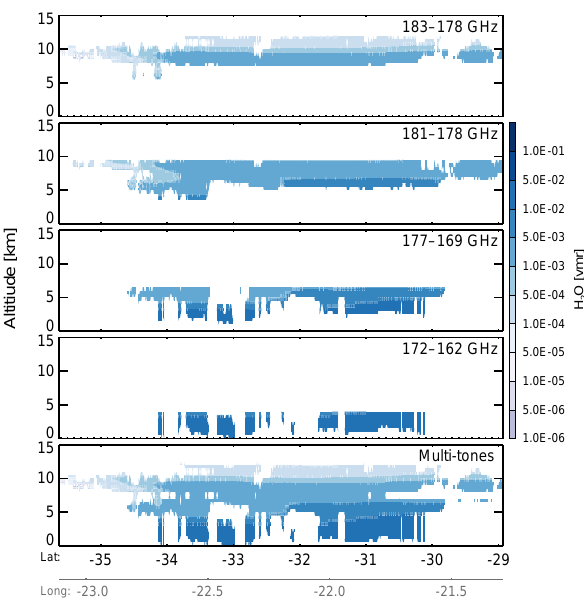
Figure 8. Cross section of CloudSat-driven water vapor retrievals. This is the same cross section as in Fig. 2c. Water vapor values are shown only for altitudes with kernels greater than 0.4, which indi- cates retrievals not influenced by the a priori. The retrieved values using the 170–160 radar tone combination are not displayed be- cause, as shown in Fig. 2b, there were no hydrometeors close to the surface.